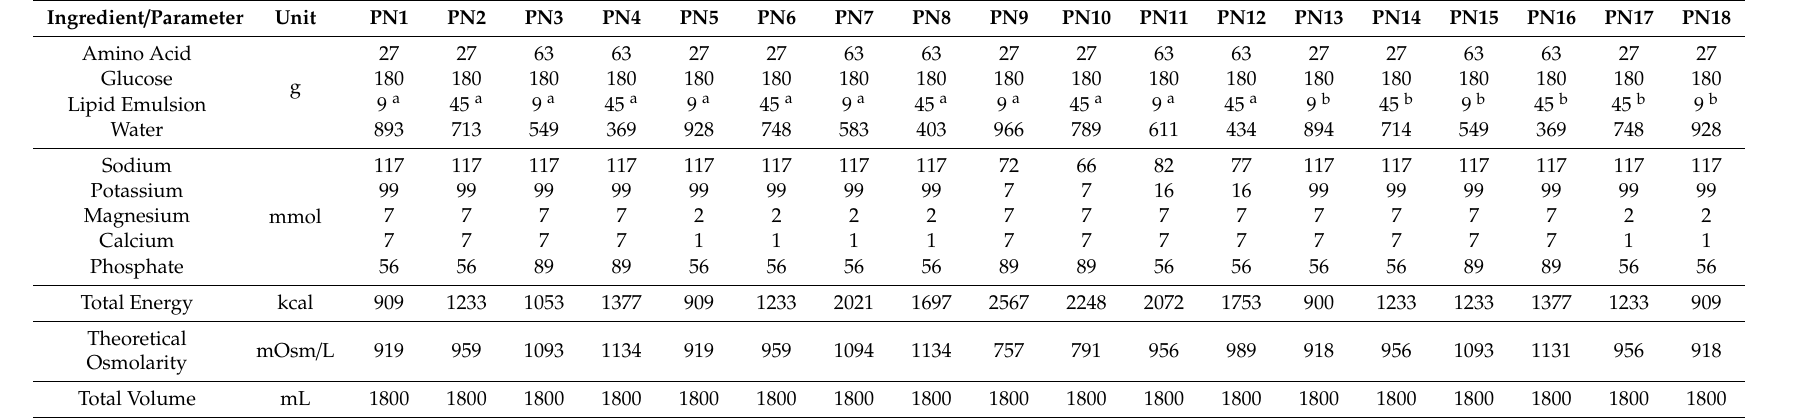
Table 1. Composition and characteristic of PN